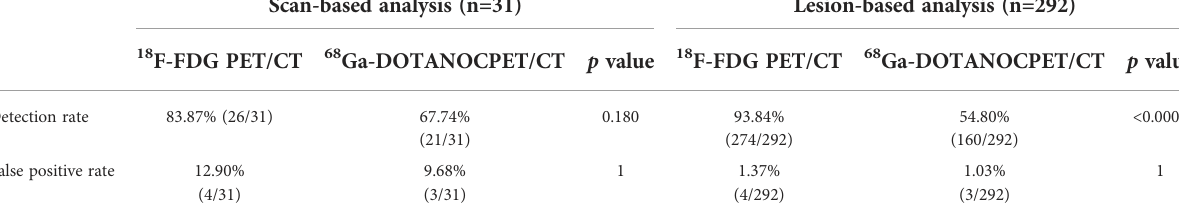
TABLE 3 PET/CT scan-based and lesion-based diagnostic results for patients with ectopic ACTH syndrome in the tumor staging group. Scan-based analysis (n=31) Lesion-based analysis